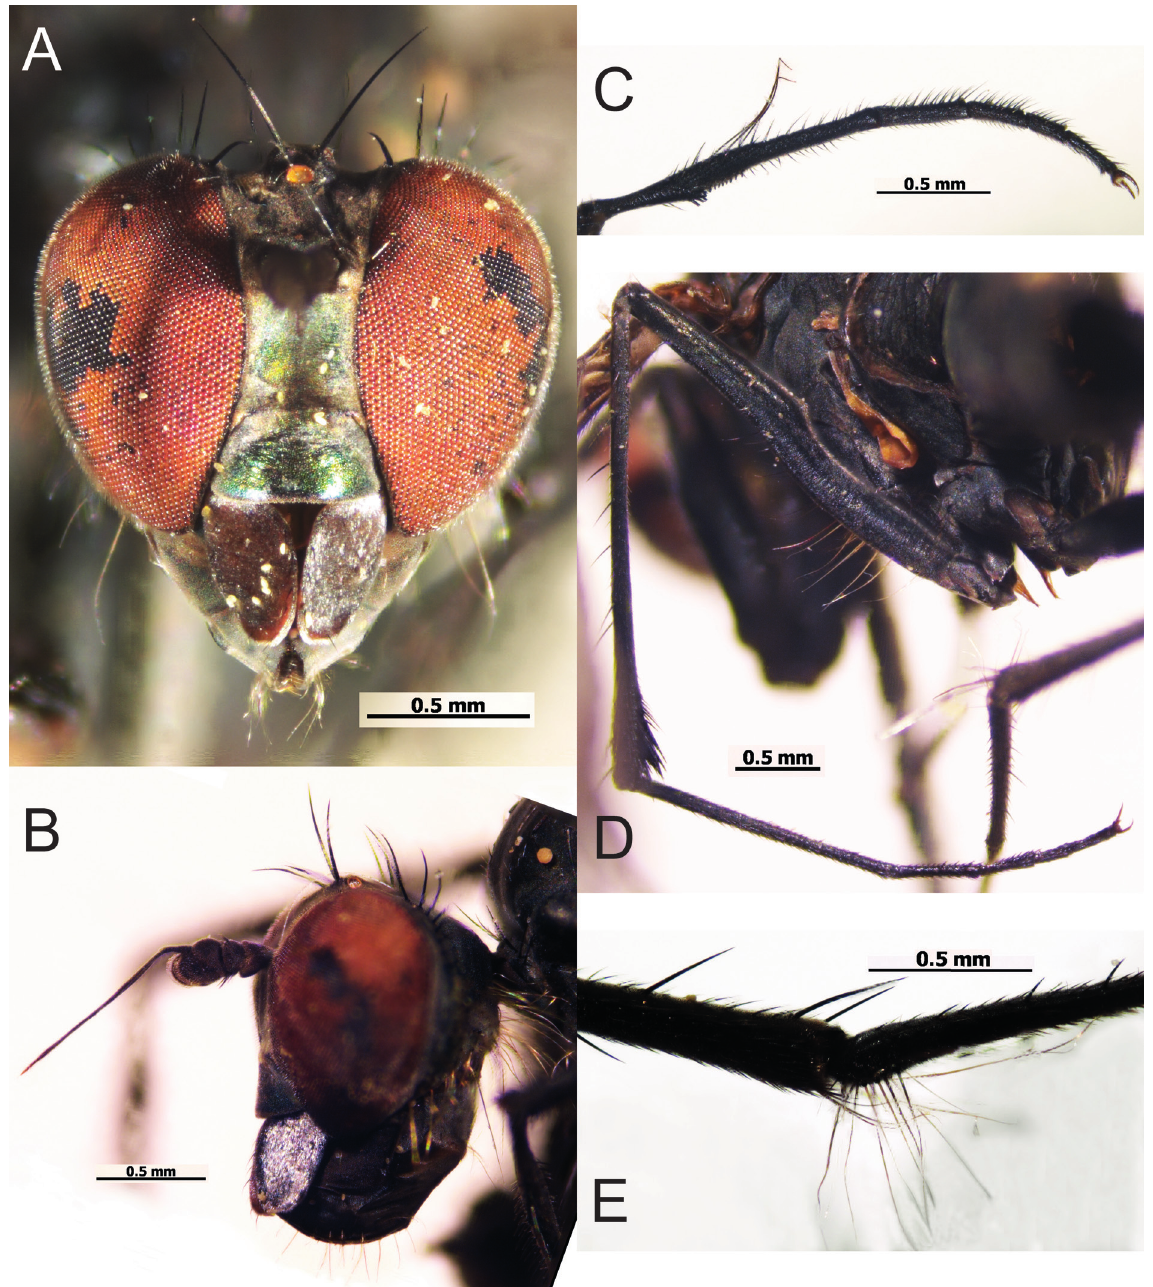
Fig. 1. Diostracus ( Sphyrotarsus ) kustovi sp. nov. Male holotype. A . Head in anterior view. B . Head in lateral view. C . Fore tarsus. D . Mid leg. E . Hind tibia in apical view and